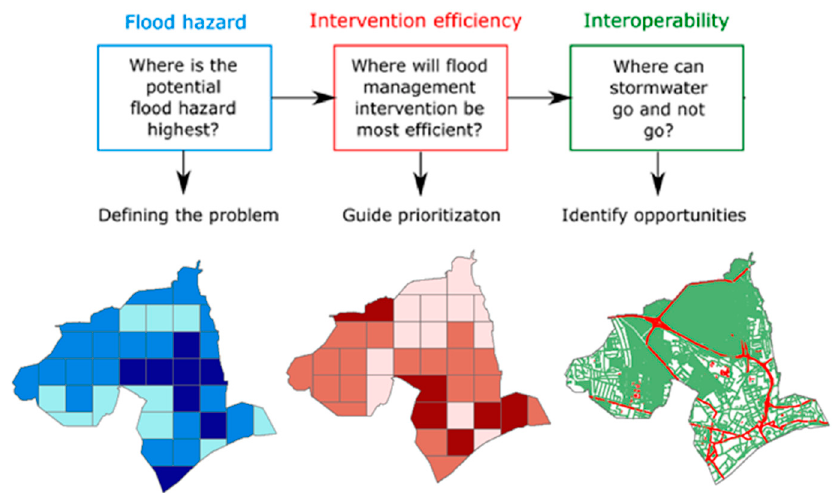
Figure 2. Geographic information system (GIS) analysis of flood impacts across Newcastle.